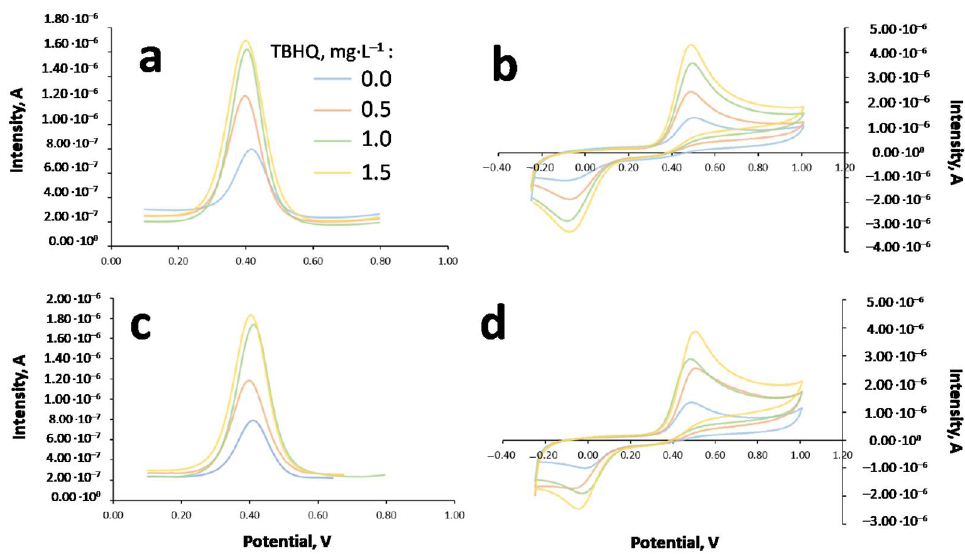
Figure 5. Voltammograms obtained for FOBL with TBHQ (2114 mg · L − 1 ) with some standard additions using different extractions and voltammetries. ( a ) Dispersive microextraction, DPV; ( b )